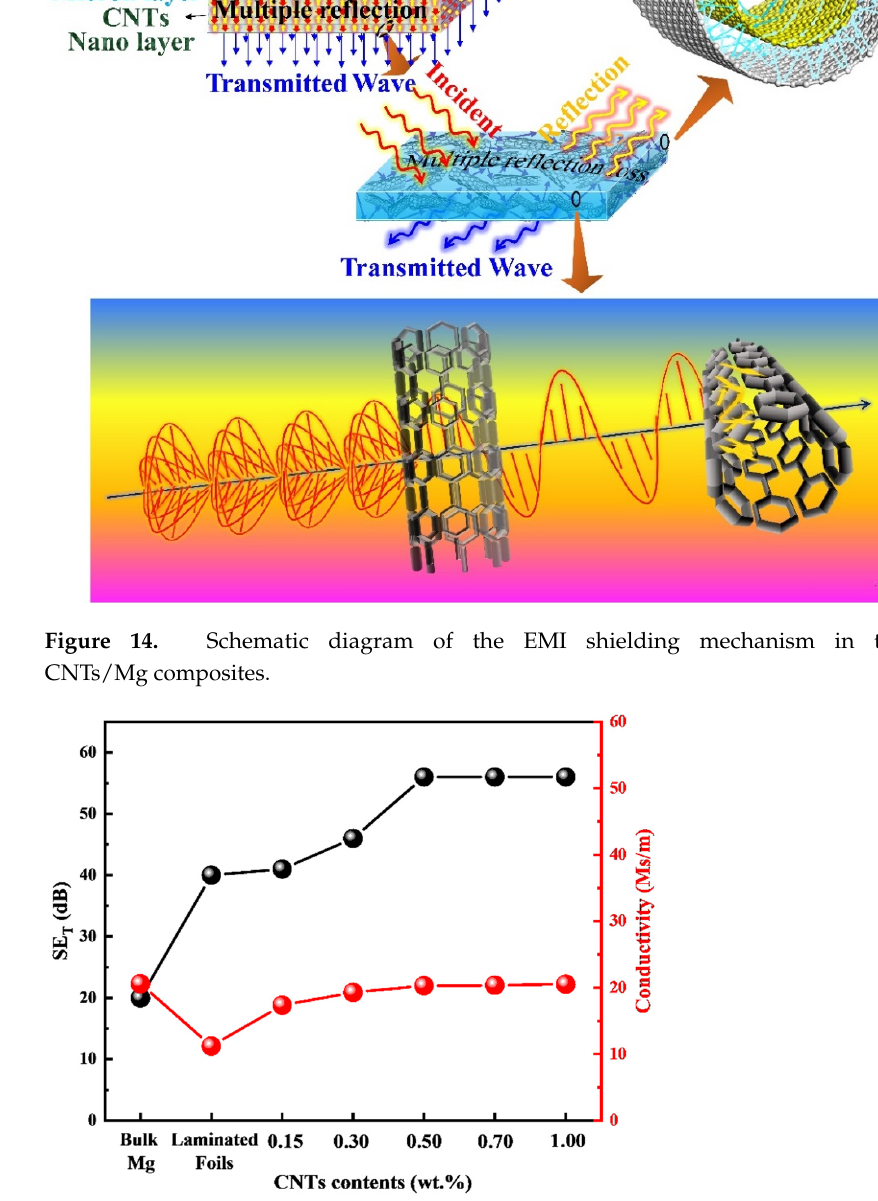
Figure 15. Electrical conductivity and corresponding EMI SE of the CNTs/Mg composites.